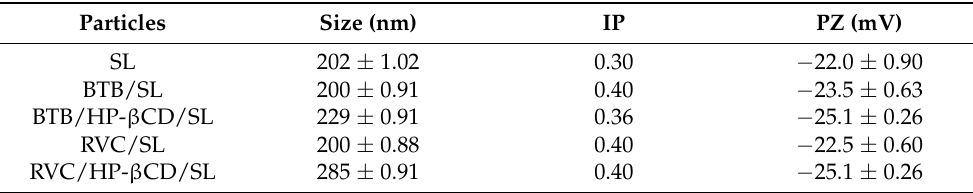
Table 4. Diameter of the vesicle liposome, polydispersity value and zeta